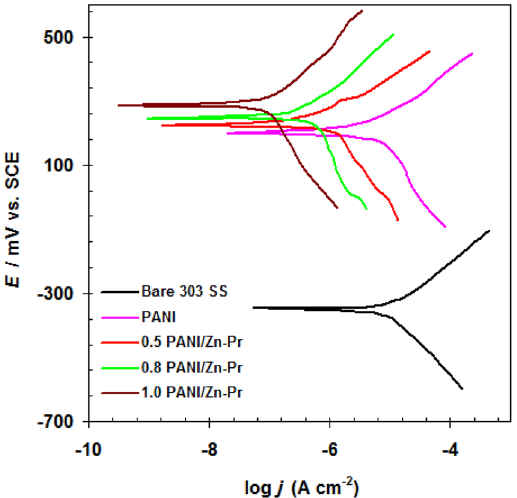
Figure 2. Polarization curves of uncoated and coated 303SS by neat PANI and PANI/Zn-Pr composites in 1.0 M H 2 SO 4 solution at 298 K.